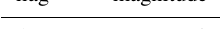
Figure 9. (a) ISS (or authors adopted by ISS) (before) and (b) ISC-GEM locations (after) for the extension events relocated be- tween 1920 and 1959. Bird (2003) plate tectonic boundaries are also shown. It is possible to observe how the ISC-GEM locations better depict the seismicity of the Earth even on a global scale.